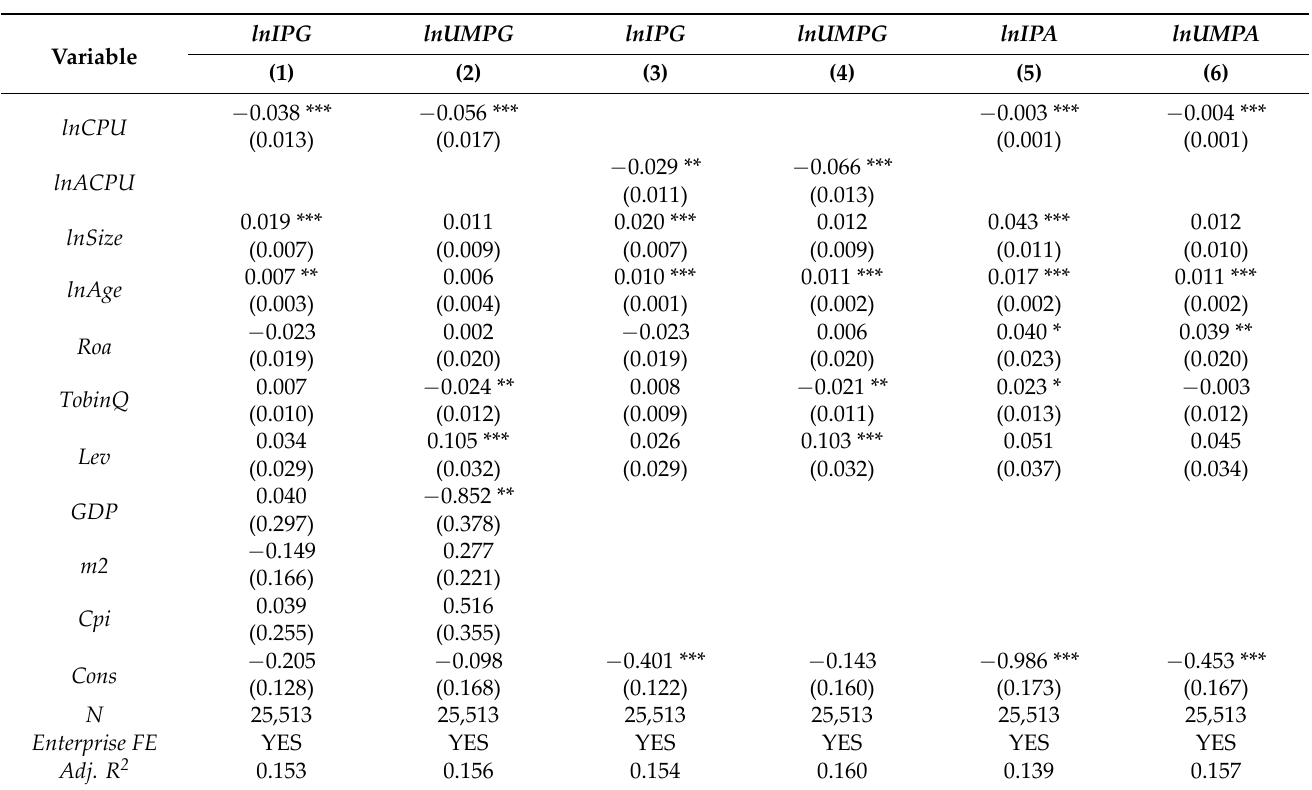
Table 4. Robustness